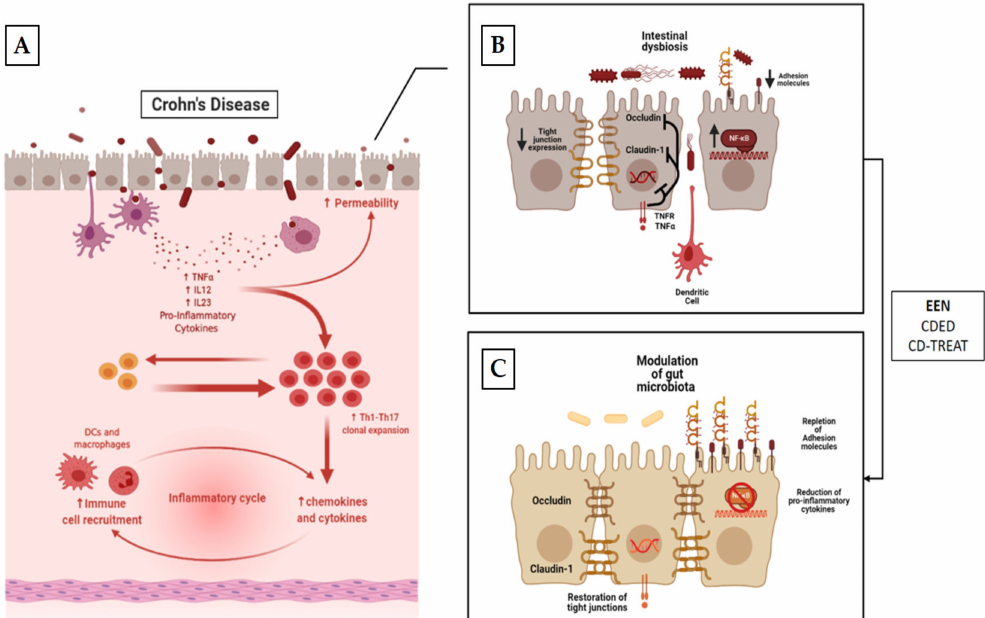
Figure 2. Mechanism of action of EEN, CDED and CD-TREAT. The panels ( A , B ) depict the potential pathogenic effects of diet on the development of CD. (i) Reduction in the expression of apical membrane adhesion molecules, which cause increased interactions between bacteria and epithelial membrane. (ii) Reduction in the synthesis and expression of lateral tight junction proteins, causing defects in gut barrier. As a consequence, there is an amplification of the interaction between gut bacteria and immune cells, causing stimulation of pro-inflammatory cytokine secretion and attracting and stimulating the proliferation of pro-inflammatory T-cells with the establishment of a pro-inflammatory milieu along with a self-empowered mechanism. Panel ( C ) describes the potential effects of nutritional interventions. (i) Modulation of gut microbiota. (ii) Enhancement of expression of apical adhesion molecules. (iii) Increased expression of tight junction with restoration of intestine permeability. (iv) Reduction in pro-inflammatory cytokines and, as a consequence, polarization of immune response towards a regulatory phenotype of T